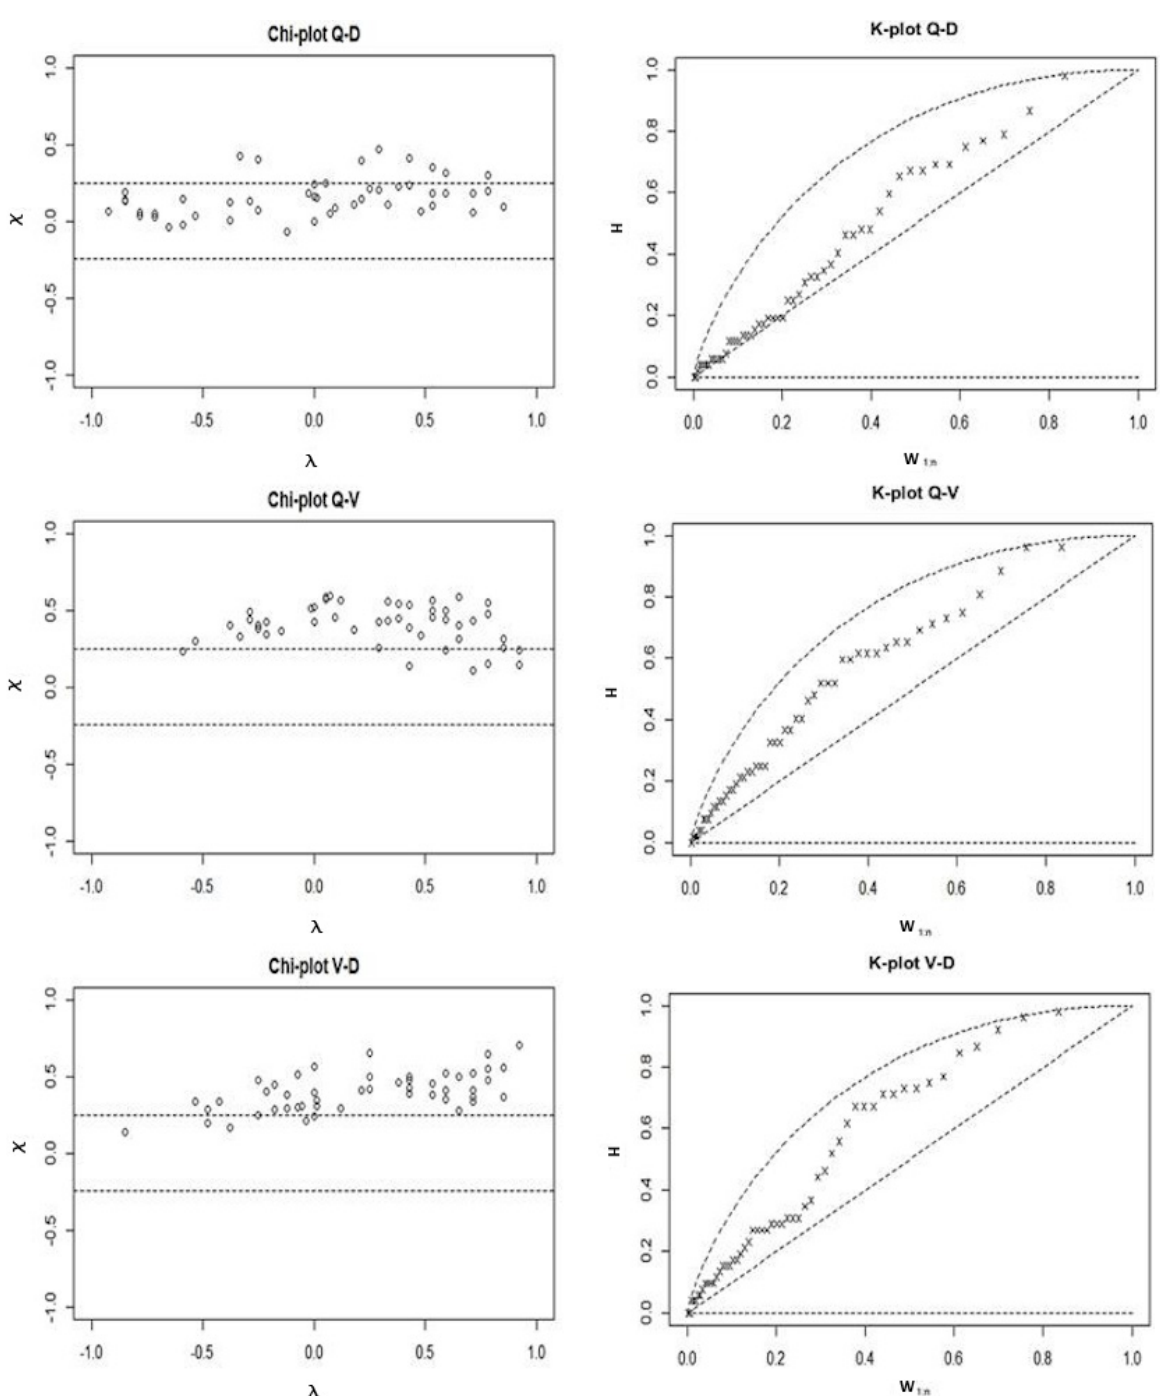
Figure 4. Example of dependence assessment for the Jasenovac GS on the Sava River.